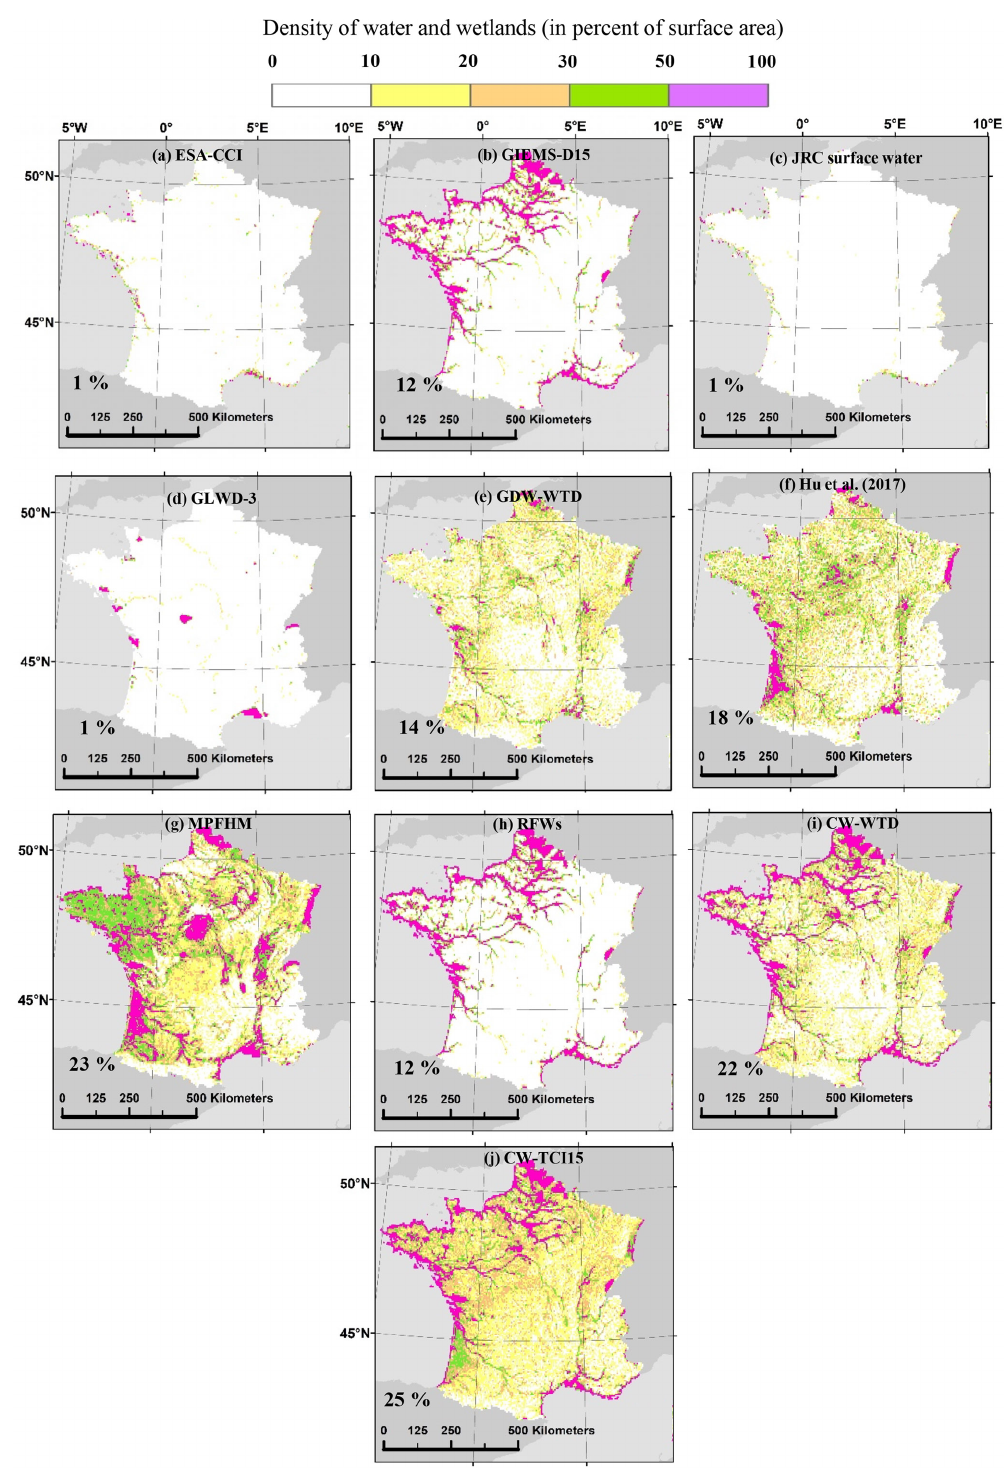
Figure 5. Maps of wetlands in France according to different water and wetland datasets: (a–c) components of RFW, (d–g) validation datasets and (h–j) datasets generated in this study. The panels also give the mean areal wetland fraction of each dataset in the study area (using the mean fraction of each fractional wetland class of GLWD-3; cf. Sect. 2.5.1). The bounds of the study are the boundaries of